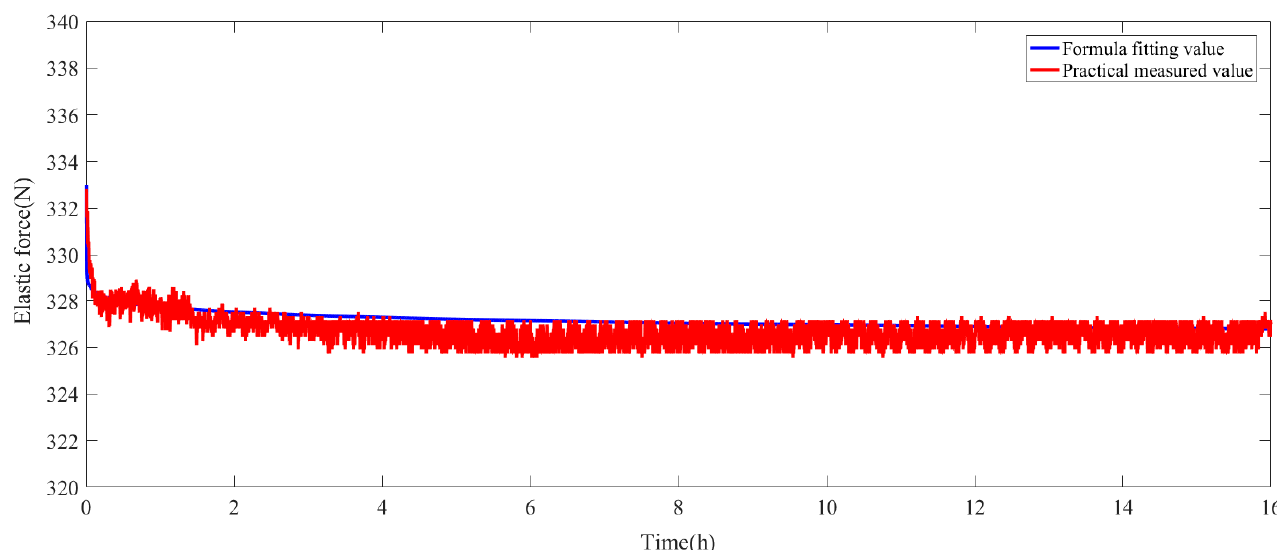
Figure 8. Distribution of elastic force-fitting and test